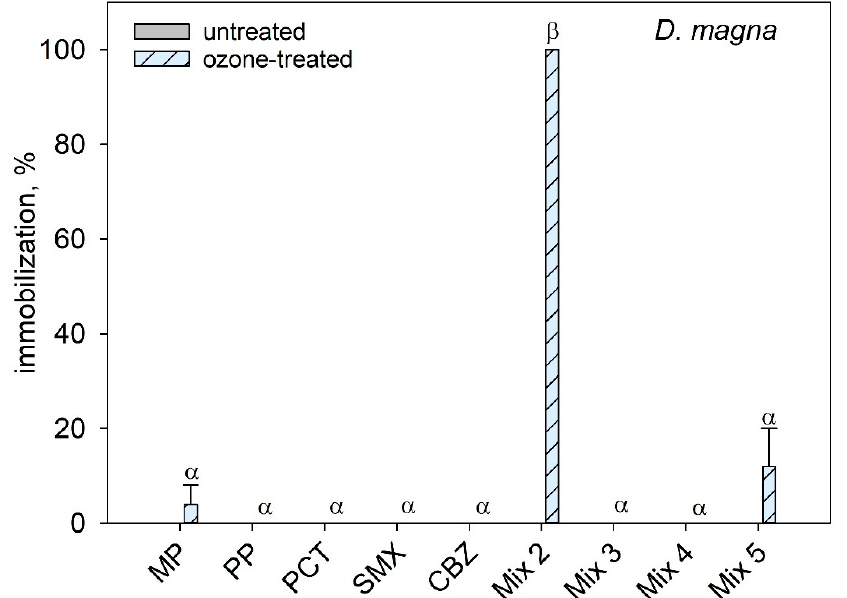
Figure 3. The immobilization of Daphnia magna after 48h of exposure to untreated and ozone-treated solutions. The bars represent the mean, and the error bars represent the standard error of the mean. Mix 2: MP+PP; Mix 3: MP+PP+PCT; Mix 4: MP+PP+PCT+SMX; Mix 5: MP+PP+PCT+SMX+CBZ. The absence of a bar means 0% immobilization. The different Greek letters indicate significant differences among ozone-treated samples.